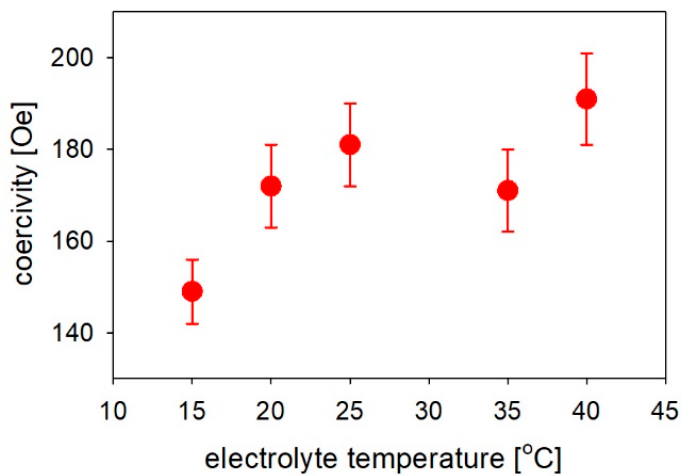
Figure 13. Coercivity values versus electrolyte temperature measured for the Fe nanowires with the magnetic field applied out of the membrane plane.